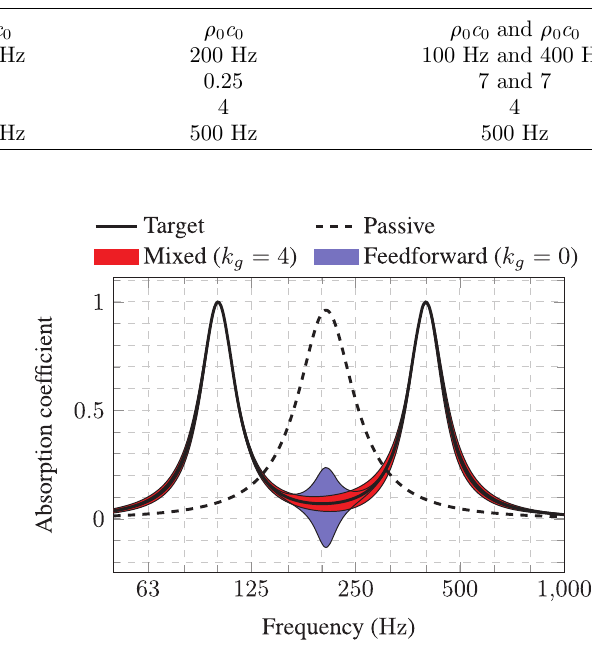
Figure 3. First and third quartiles of the achieved absorption for the single-degree-of-freedom absorber with 10 5 random relative errors of 5% standard deviation on the fi ve estimated parameters.